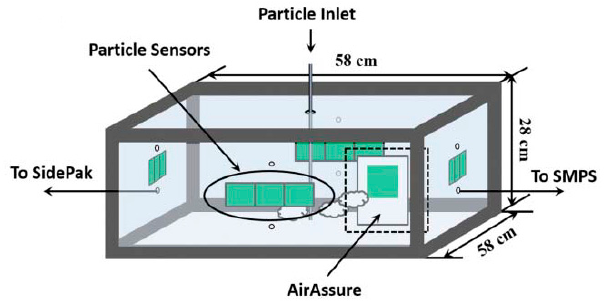
Figure 7. Schematic of the chamber for particle measurements and the arrangement of particle sensors, developed by Wang Yang (2015). A SidePak Personal Aerosol Monitor AM510 (TSI Inc.), a scanning mobility particle sizer (SMPS, TSI Inc.), and an Air-Assure PM2.5 Indoor Air Quality Monitor (TSI Inc.) were used to provide reference measurement results to evaluate the performance of the sensors (image reprinted with permission provided by Taylor and Francis and Copyright